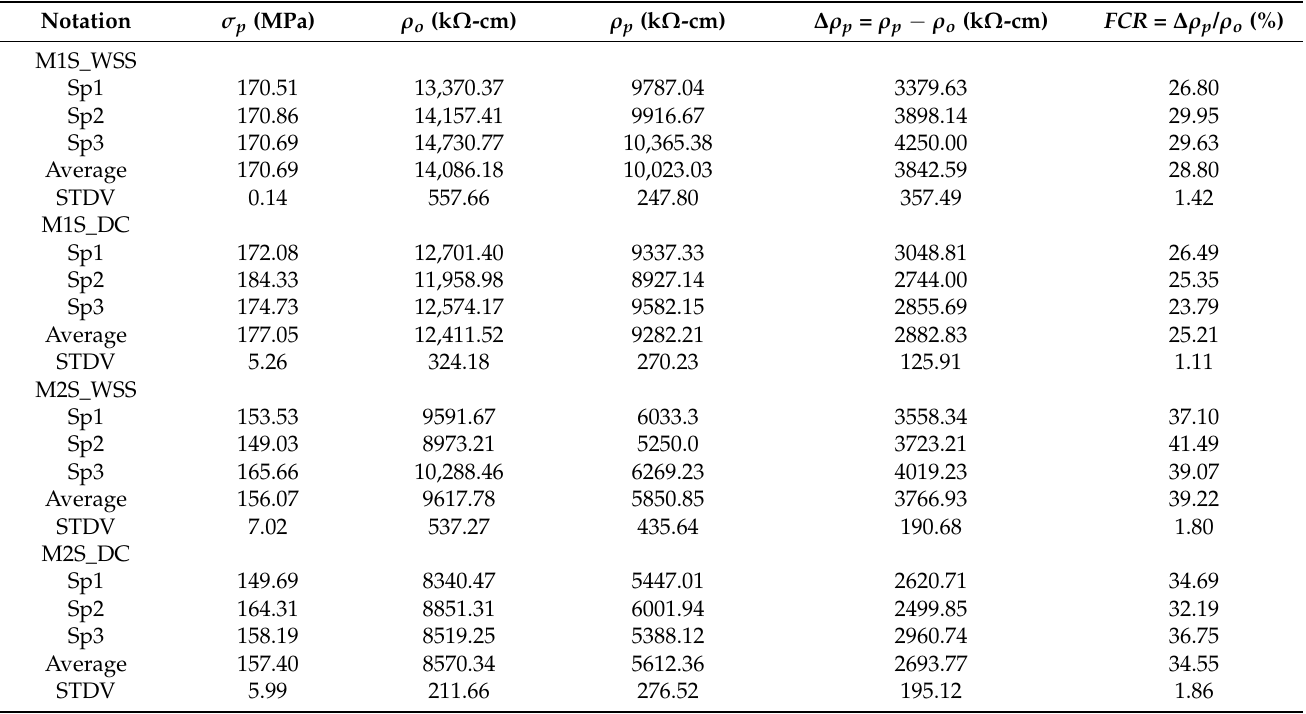
Table 4. Compressive–resistivity test results. Figure 14. Electrical resistivity response of S-UHPCs under compression.